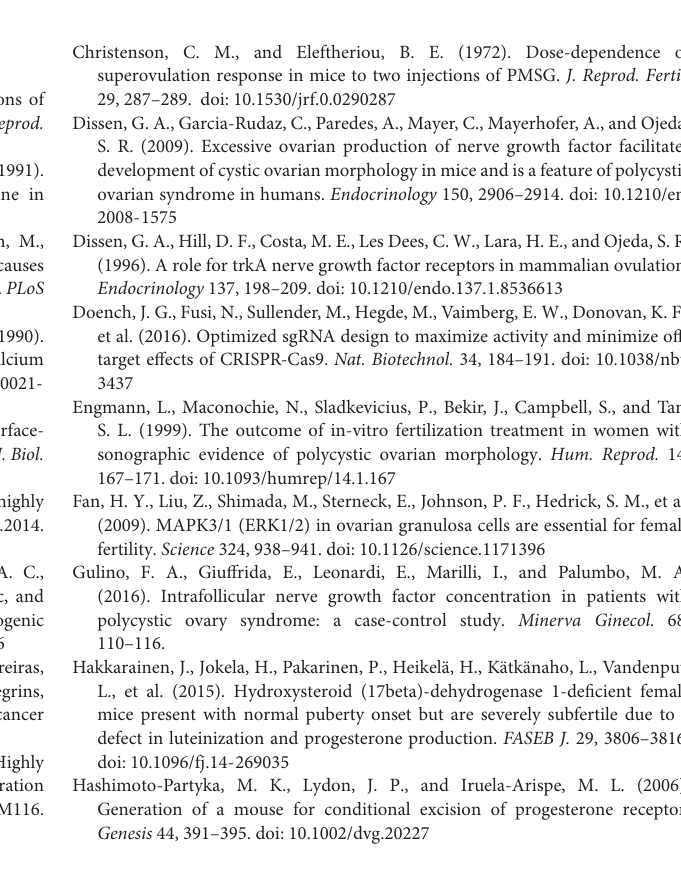
oocyte is ovulated at estrus after which the remaining follicle goes through luteinization and forms corpus luteum (CL). Active secretion of progesterone from CL peaks at diestrus followed by luteolysis of the CL cells and resumption of proestrus. Supplementary Figure 2 | CRISPR-EZ results. (A) Genotyping of the 17 mice born after implantation of 78 CRISPR-EZ treated 2-cell stage embryos showed seven pups with a deletion of Abhd2 exon 6. Two of the mice, marked in red, were chosen for further phenotypic analysis. (B,D) Sequencing of the shorter Abhd2 KO product, obtained after genotyping PCR of the founder mice, showed a deletion of exon 6 starting in the surrounding introns. The chromatograms correspond to the sequence marked in red, with arrows pointing to the ligation site of the two introns. (C,E) Superovulation results from pups born from the two founder mouse lines display similar increase in number of ovulated eggs. Supplementary Figure 3 | Abhd2 ablation does not alter the weight or the glucose uptake of mice. (A,B) The weight of 2-4-month-old female mice and ovaries from 3 to 4-month-old mice in proestrus did not differ between genotypes. (C) Average values of glucose tolerance test of 2.5-month-old female mice, fasted overnight and thereafter given an intraperitoneal injection of 2 g/kg glucose. (D) The individual measurements of the mice used for the glucose tolerance test in panel (C) . No statistical difference was detected in glucose uptake when comparing Abhd2 + / + , Abhd2 + / − , and Abhd2 − / − mice. Supplementary Figure 4 | Estrous cycle of Abhd2 − / − mice. The estrous cycle measured for 1 month in mice used for the analysis in Figure 3F . Supplementary Figure 5 | ABHD2 in different brain regions of mice. ABHD2 was detected in lateral (LCP) and 4th ventricle choroid plexus (4thCP) by Western blot, while the main olfactory bulb (OB), the cerebral cortex (CTX), the hippocampus (HIP) and the cerebellum (CB) of female mice only show background staining. Samples were collected from a 2.5-month-old Abhd2 + / + female